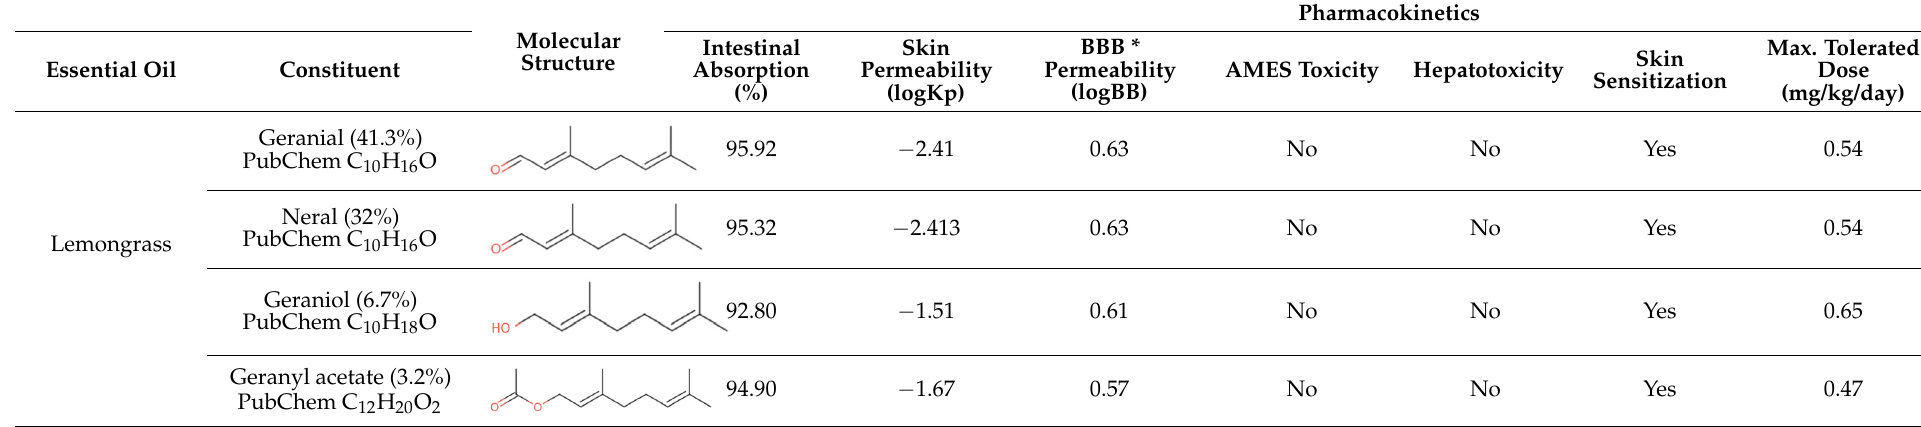
Intestinal absorption in humans measures the percentage of drug absorption from an orally administered solution, being considered poorly absorbed for values <30%. All the components of EOT and EOL demonstrated high percentages of intestinal absorption, above 90%, with thymol and carvacrol being the constituents presenting the lowest per- centages. Skin permeability is an absorption property that refers to transdermal drug de- livery (expressed as skin permeability, constant logKp), and a compound is considered to have relatively low permeability at logKp > − 2.5. Accordingly, all components of the two EOs have low skin permeability, with geranial and neral, both present on lemongrass es- sential oil, being the ones with the highest permeability values. This prediction is not